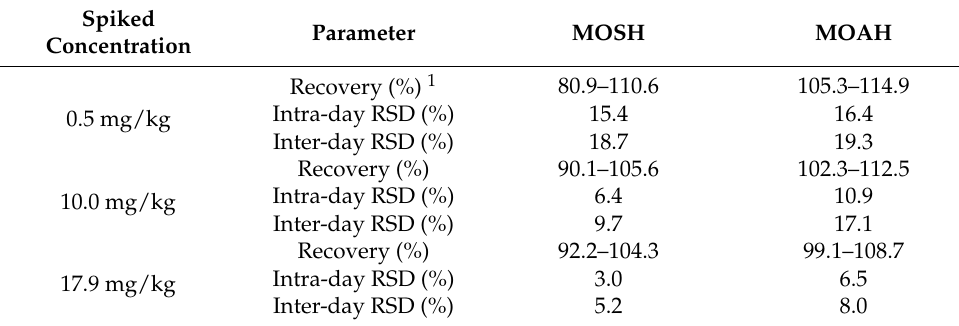
Table 1. Recovery and precision values obtained during the method validation. Spiked